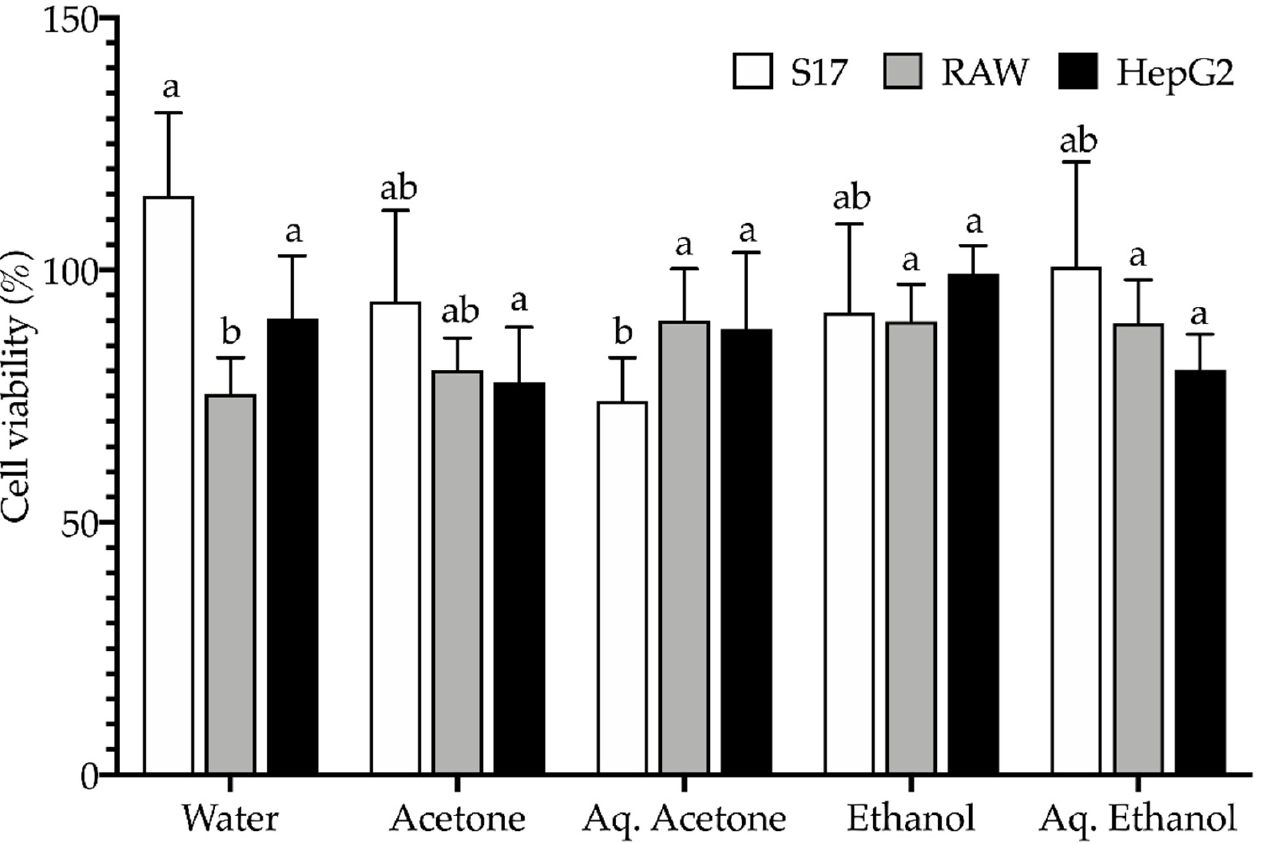
Figure 4. Cellular viability (%) after application of extracts (100 μ g/mL extract DW) from Cladium mariscus (sawgrass) seeds on mammalian cell lines: S17, RAW 264.7, and HepG2. Cells treated only with cell culture medium were used as controls. Values represent the mean ± standard deviation (SD) of at least three experiments performed in triplicate ( n = 9). For each cell line, different letters “a, b” mean significant differences ( p < 0.05).